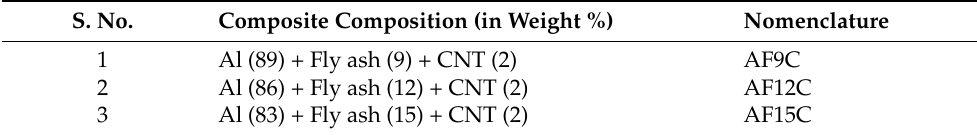
Table 1. Composite Nomenclature used in the experiment.